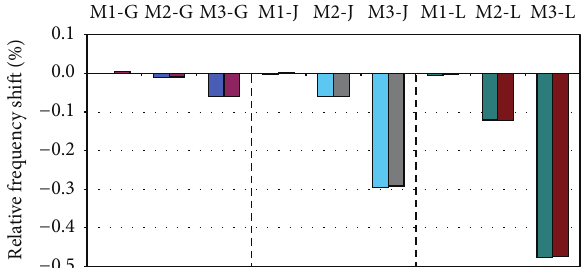
Figure 9: The relative frequency shifts analytically derived (left bars for each mode) and evaluated by FEA (bars positioned at right) for the mass increase on a narrow segment.